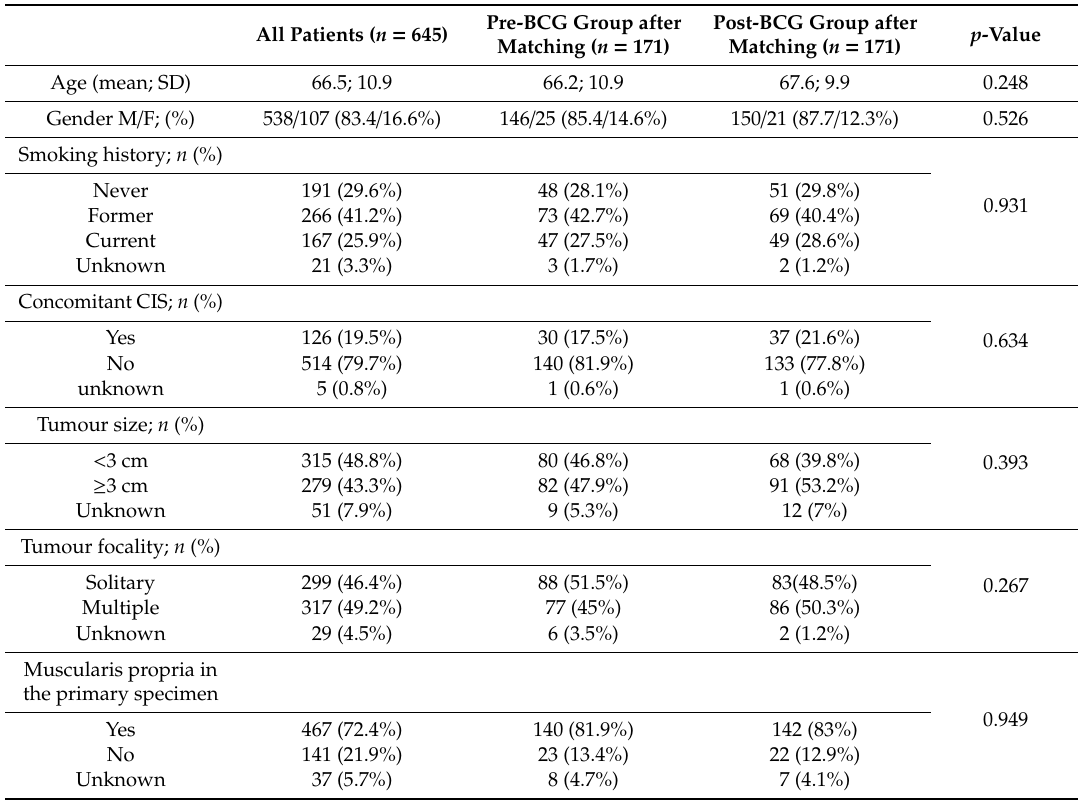
Table 3. The patients’ baseline characteristics after propensity-score-matched analysis (PSM). Chi 2 and Mann–Whitney test p -values of the di ff erences between the two study groups. Pre-BCG Group after All Patients ( n = 645) Matching ( n =